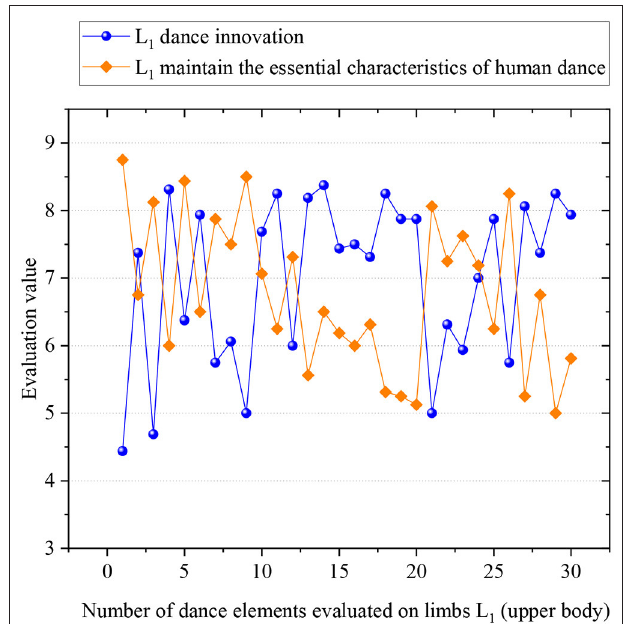
FIGURE 13 | Evaluation scores of robot-imagined 30 new dance elements on L 2